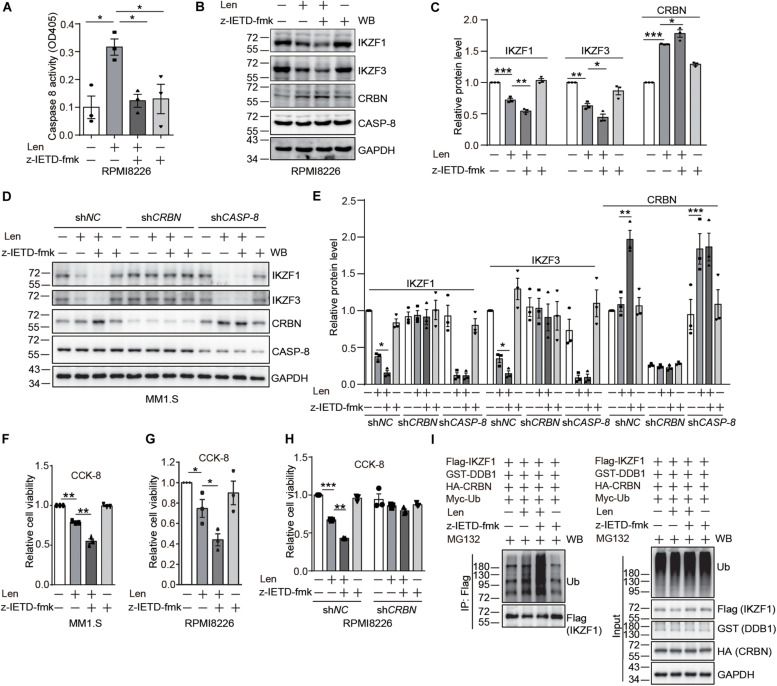
CASP-8 inhibition potentiates the anti-myeloma activity of Len. (A) Len enhances CASP-8 activity. RPMI8226 cells were pretreated with DMSO or z-IETD-fmk (40 μM) for 30 min and then treated with DMSO or Len (10 μM) for 24 h. CASP-8 activity was measured using a CASP-8 fluorometric assay kit. Mean ± SEMs from three independent biological replicates were plotted. Student’s t-test, *P < 0.05. (B) CASP-8 inhibitor z-IETD-fmk enhances the Len-mediated reduction of transcription factors IKZF1 and IKZF3 in RPMI8226 cells. RPMI8226 cells were pretreated with DMSO or CASP-8 inhibitor z-IETD-fmk (40 μM) for 30 min and then treated with DMSO or Len (10 μM) for 24 h. The resulting cell lysates were immunoblotted with the indicated antibodies. (C) Quantitative data (mean ± SEMs) for (B) were from three independent biological replicates. Student’s t-test, *P < 0.05, **P < 0.01, ***P < 0.001. (D) CASP-8 inhibitor z-IETD-fmk enhances the Len-mediated reduction of transcription factors IKZF1 and IKZF3 in stable MM1.S knockdown cell lines. The stable shNC, shCRBN, and shCASP-8 MM1.S cell lines were pretreated with DMSO or CASP-8 inhibitor z-IETD-fmk (40 μM) for 30 min and then treated with DMSO or Len (10 μM) for 3 h. The resulting cell lysates were immunoblotted with the indicated antibodies. (E) Quantitative data (mean ± SEMs) for (D) were from three independent biological replicates. Student’s t-test, *P < 0.05, **P < 0.01, ***P < 0.001. (F) CASP-8 inhibitor enhances Len-mediated reduction of cell viability in MM1.S cell line. MM1.S cells were pretreated with DMSO or z-IETD-fmk (40 μM) for 30 min and then treated with DMSO or Len (10 μM) for 48 h. The relative cell viability was measured with CCK-8 assay. Mean ± SEMs from three independent biological replicates. Student’s t-test, **P < 0.01. (G) CASP-8 inhibitor enhances Len-mediated reduction of cell viability in RPMI8226 cell line. RPMI8226 cells were pretreated with DMSO or z-IETD-fmk (40 μM) for 30 min and then treated with DMSO or Len (10 μM) for 48 h. The relative cell viability was measured with CCK-8 assay. Mean ± SEMs from three independent biological replicates. Student’s t-test, *P < 0.05. (H) CASP-8 inhibitor enhances Len-mediated reduction of cell viability in a CRBN-dependent manner. RPMI8226 cells were infected with shNC or shCRBN lentiviruses for 16 h and then treated as described in (G). Student’s t-test, **P < 0.01, ***P < 0.001. (I) CASP-8 inhibitor z-IETD-fmk enhances the Len-mediated ubiquitination of IKZF1. HEK293T cells were transfected with Flag-IKZF1, HA-CRBN, GST-DDB1, and Myc-Ub and split to four 6-cm plates. At 48 h post-transfection, cells were pretreated with DMSO or z-IETD-fmk (40 μM) for 30 min, then with DMSO or Len (10 μM) for 1 h, and again with MG132 (10 μM) for 12 h. The Flag tagged IKZF1 was purified with anti-Flag affinity gel, and the purified samples and whole cell lysates were immunoblotted with the indicated antibodies.